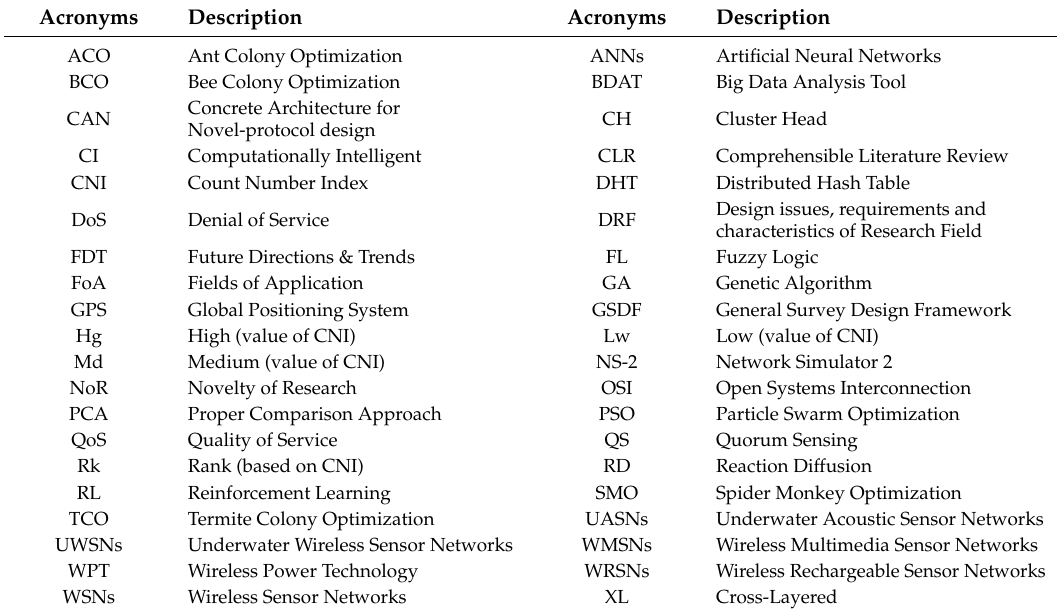
Table 1. Listing of acronyms with